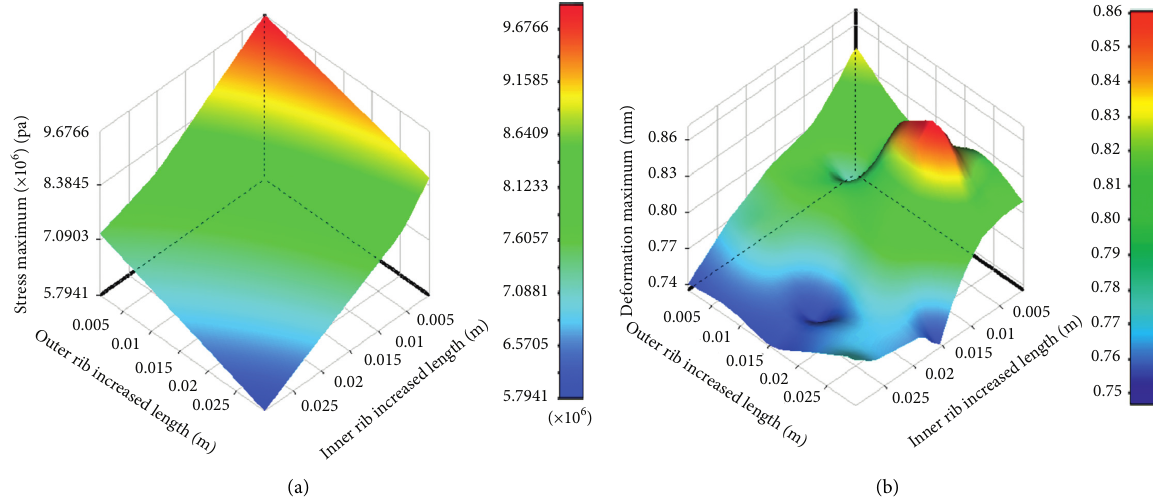
Figure 14: The response surface of the feeder’s stress and deformation varying with the length of the rib-stiffened plates on both sides: (a) first principal stress response surface; (b) deformation response